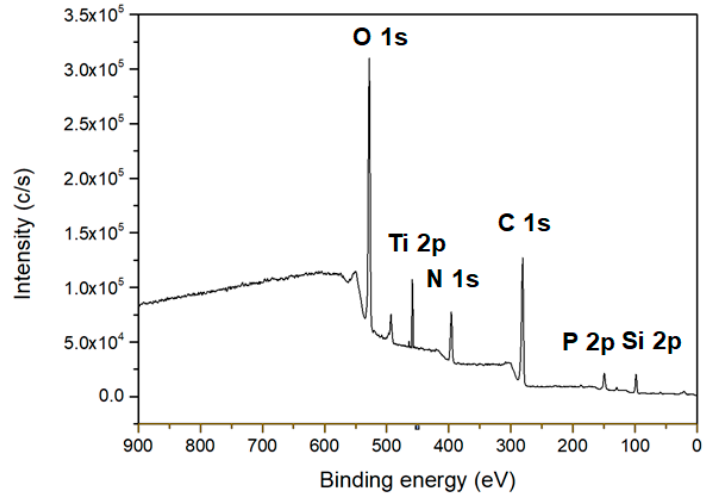
Figure 5. XPS survey spectra of the surface of fabricated TiO 2 -DNA biosensor.